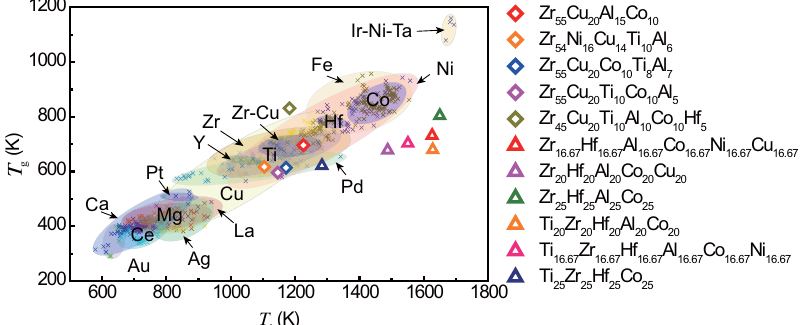
Fig. 4 Summary of glass transition temperature versus liquidus temperature of various MGs. The T g – T l diagram of reported MGs and our 12